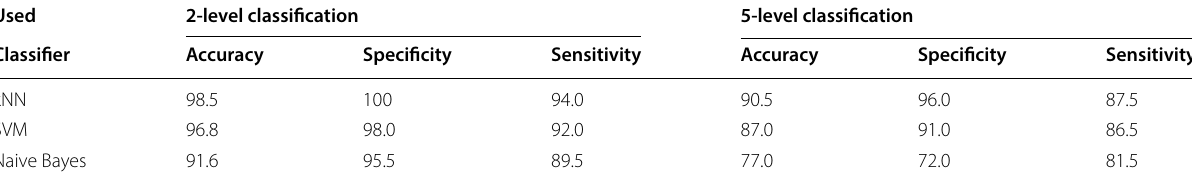
Table 7 Classification accuracy, specificity and sensitivity for the rest tremor analysis Used 2‑level